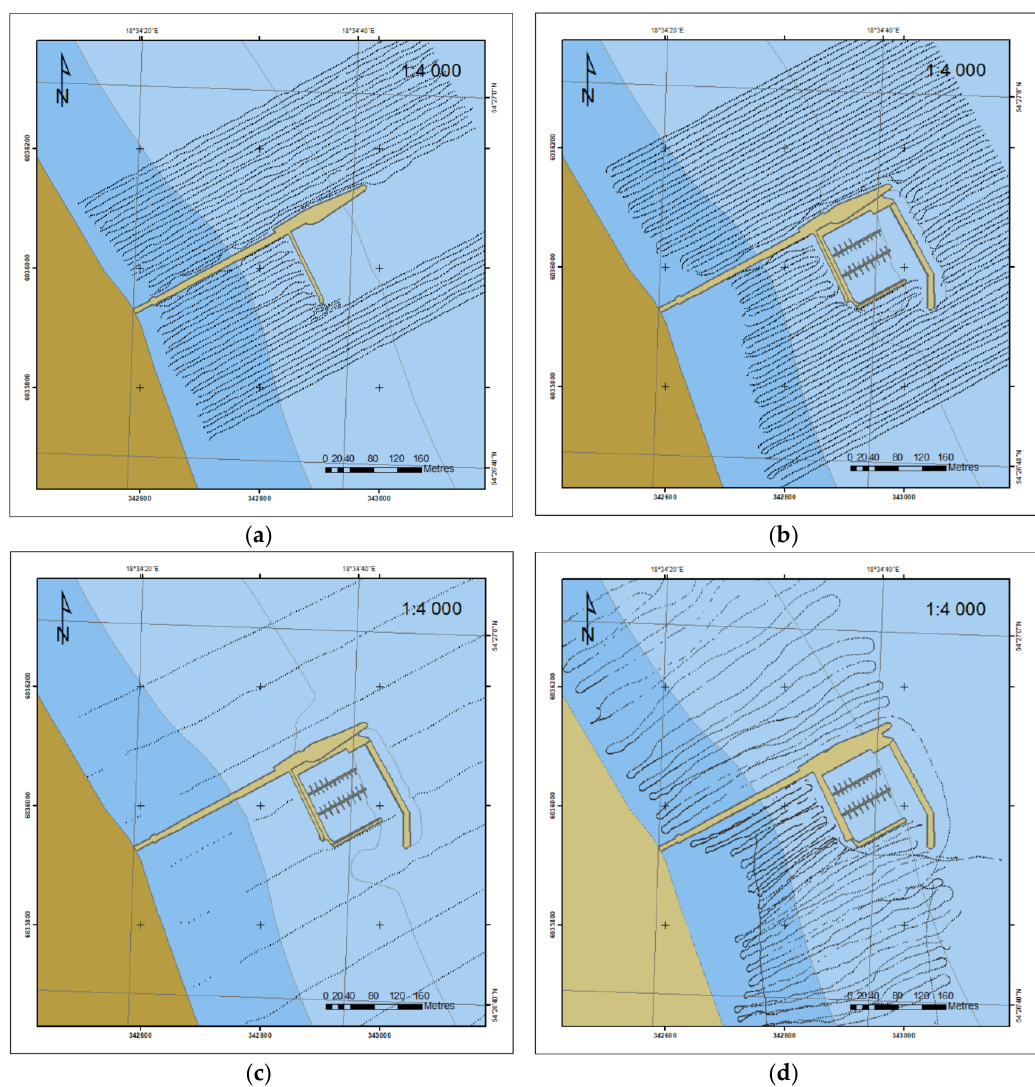
Figure 5. Data coverage with SBES survey in 2010 ( a ), 2012 ( b ) 2015 ( c ) and 2018 ( d ).